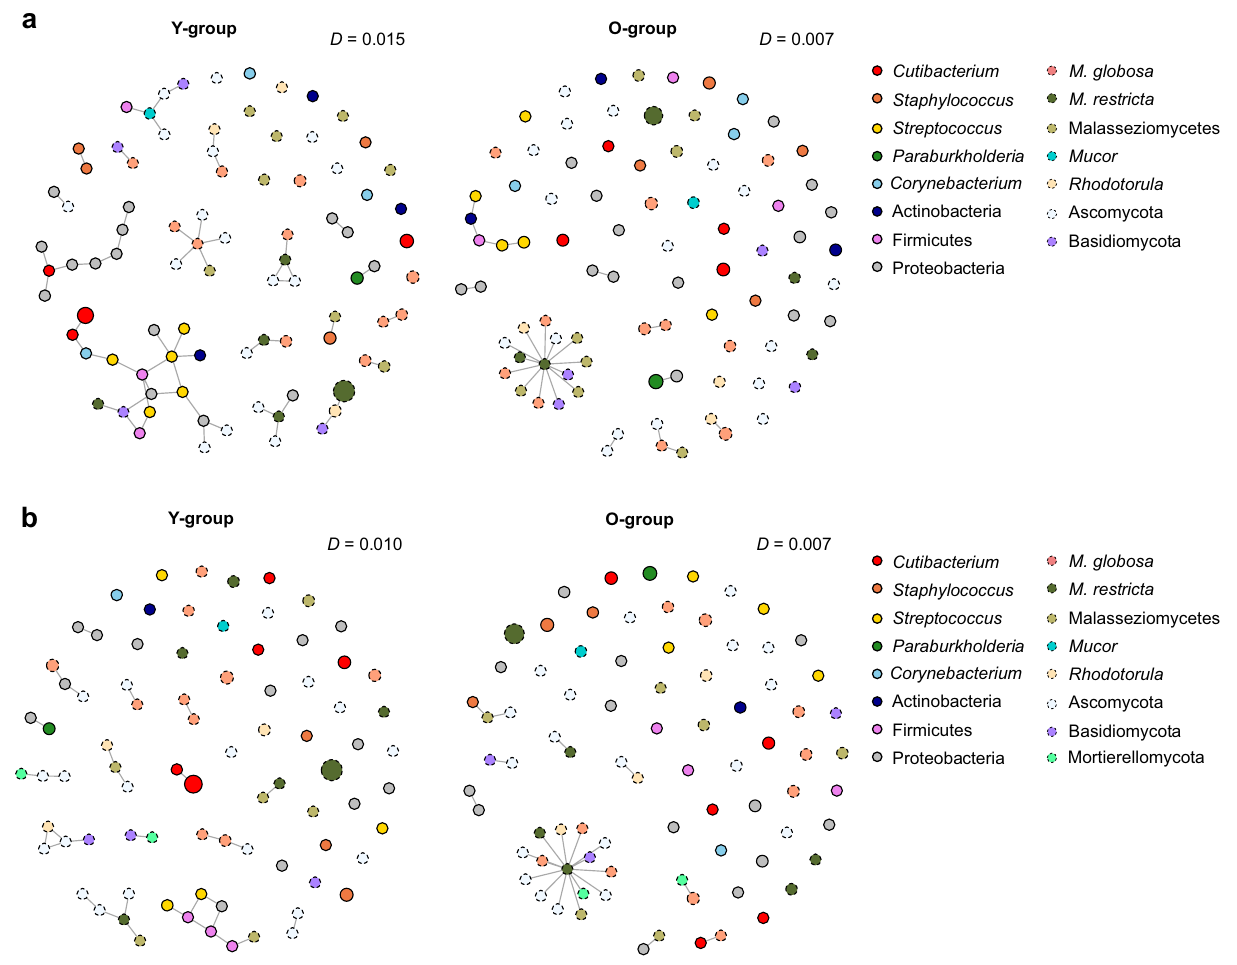
Figure 5. Network analysis of the ASVs on ( a ) cheeks and ( b ) forehead of Korean women. Each node represents the ASV and the size of the node is based on relative abundance of each ASV. Color markings indicate the major taxa except for unidentified bacteria or fungi. Shapes represent the level of kingdom, Bacteria (bold) and Fungi (dotted line). The ASVs were selected for bacterial ASVs found in more than half of all samples on the cheeks and forehead, respectively, and for the fungal ASVs with a relative abundance of more than 0.1% in each of the cheeks and forehead samples. The D value is network density calculated using the ratio of the number of